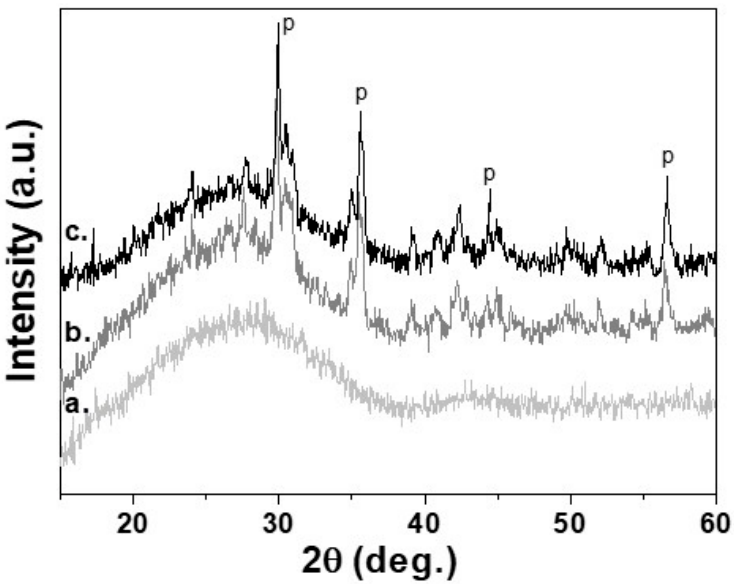
Figure 3. XRD patterns of a. Parent glass, b. Glass-ceramics isothermally sintered at 950 °C for 1 min; c. Glass-ceramics isothermally sintered at 950 °C for 30 min. “P” referes to the peaks of pyroxene crystal phase.